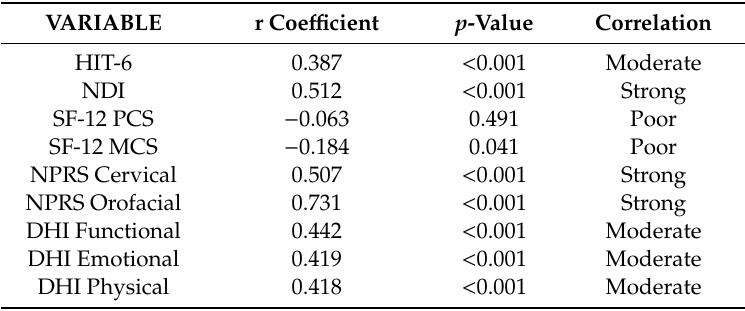
Table 6. Concurrent validity measured by Pearson Correlation.